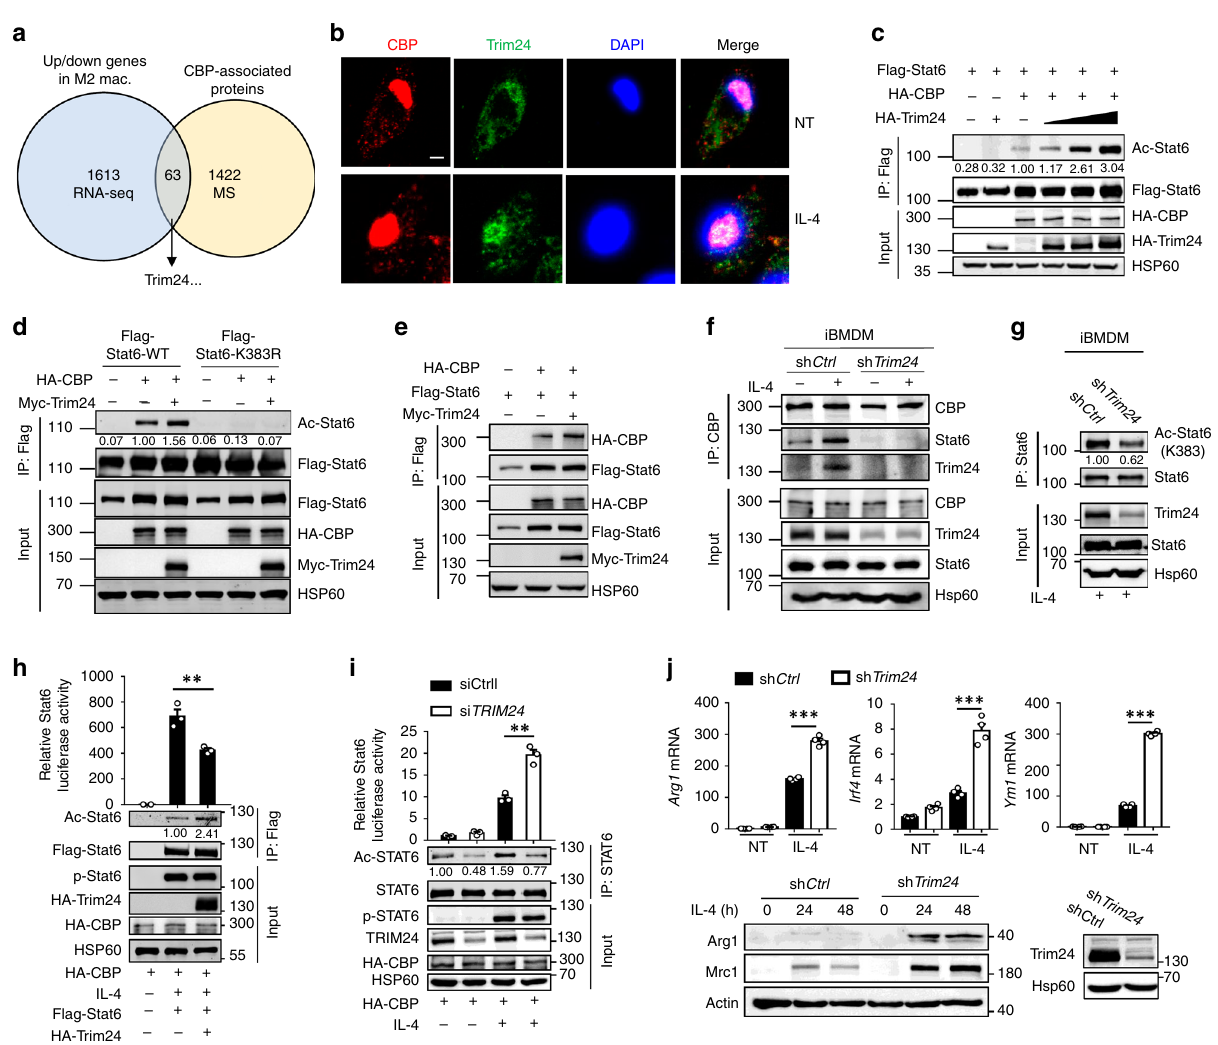
Fig. 3 Trim24 promoted CBP-induced Stat6 acetylation. a Venn diagram showing the number of genes up/downregulated in M2-polarized macrophages and those that encode CBP-associated proteins. b Confocal microscopy images showing the intracellular localization of Trim24 and CBP in peritoneal macrophages that were left nontreated (NT) or stimulated with IL-4 for 30 min, with DAPI staining used to indicate the nuclei of the cells. Scale bars: 5 μ m. c , d Immunoblot analysis of the lysine acetylation of Stat6 in 293T cells transfected with the indicated expression vectors assessed by immunoprecipitation (IP) with anti-Flag and immunoblotting with anti-Ac-Lys and anti-Flag. e , f Interaction between CBP, Stat6, and Trim24 in 293T cells transfected with the indicated expression vectors ( e ) and control and Trim24- knockdown iBMDMs that were left unstimulated ( − ) or stimulated with IL-4 ( + ) for 30min ( f ) assessed by immunoprecipitation (IP) with anti-Flag or anti-CBP and immunoblotting with anti-HA and anti-Flag, or anti-CBP, anti-Stat6, and anti-Trim24. g Immunoblot analysis of endogenous lysine acetylation of Stat6 in control and Trim24 -knockdown iBMDMs stimulated with IL-4 for 30 min assessed by immunoprecipitation (IP) with anti-Stat6 and immunoblotting with anti-Ac-Stat6 (K383) and anti-Stat6. h , i Luciferase assay to assess Stat6 transcriptional activity in 293T cells transfected with the indicated expression vectors ( h ) and 293T cells transfected with scramble (siCtrl) or si TRIM24 ( i ) stimulated with ( + ) or without ( − ) IL-4 (50 ng mL − 1 ) for 4h before detection. Immunoblot of acetylated (Ac − ) Stat6 after immunoprecipitation; phosphorylated (P − ) Stat6, HA-CBP, HA-Trim24, or Hsp60 in whole-cell lysates were applied as controls. j QPCR and immunoblot analysis of M2 gene expression in control and Trim24- knockdown iBMDMs that were left nontreated (NT) or stimulated with IL-4, and the immunoblot of Trim24 and Hsp60 to detect the knockdown ef fi ciency. Data with error bars are represented as mean± SD. Each panel is a representative experiment of at least three independent biological replicates. ∗ p < 0.05, ∗∗ p < 0.01, ∗∗∗ p < 0.001 as determined by the unpaired Student ’ s t test. Source data are provided as a Source Data fi